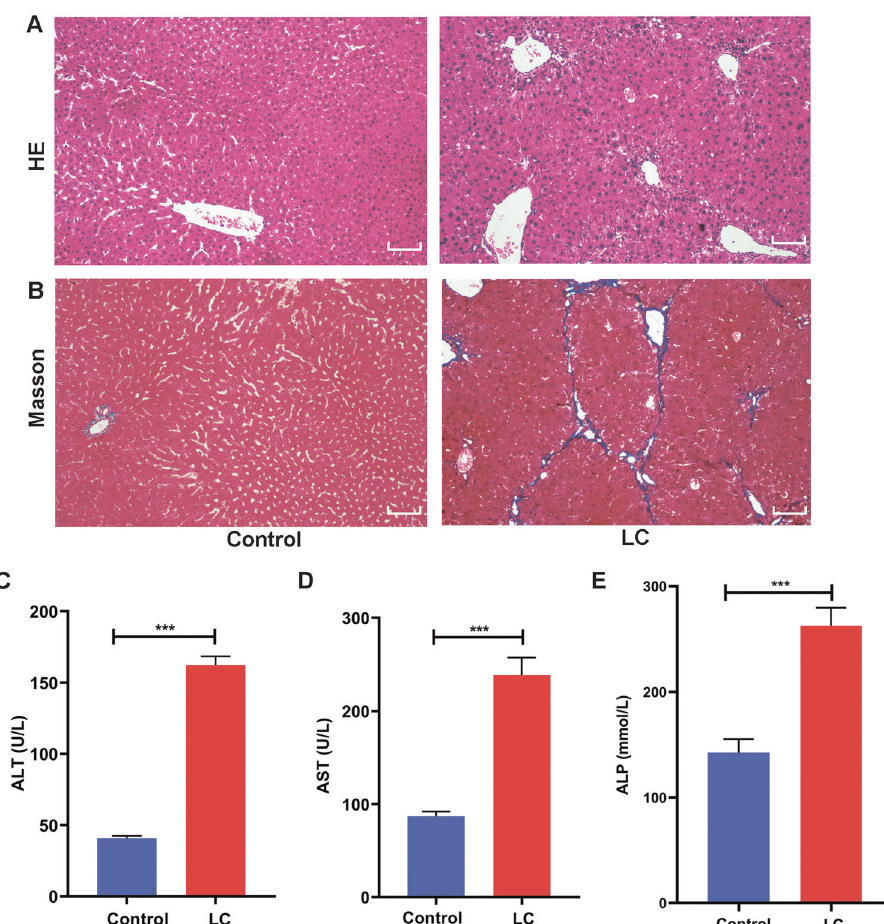
Fig. 4 Veri fi cation of the LC model. A , B HE staining and Masson staining in the control group and the LC group. C , D , E Comparison of the liver serological indices of ALT, AST, and ALP in the control group and the LC group. Scale bar = 50 μ